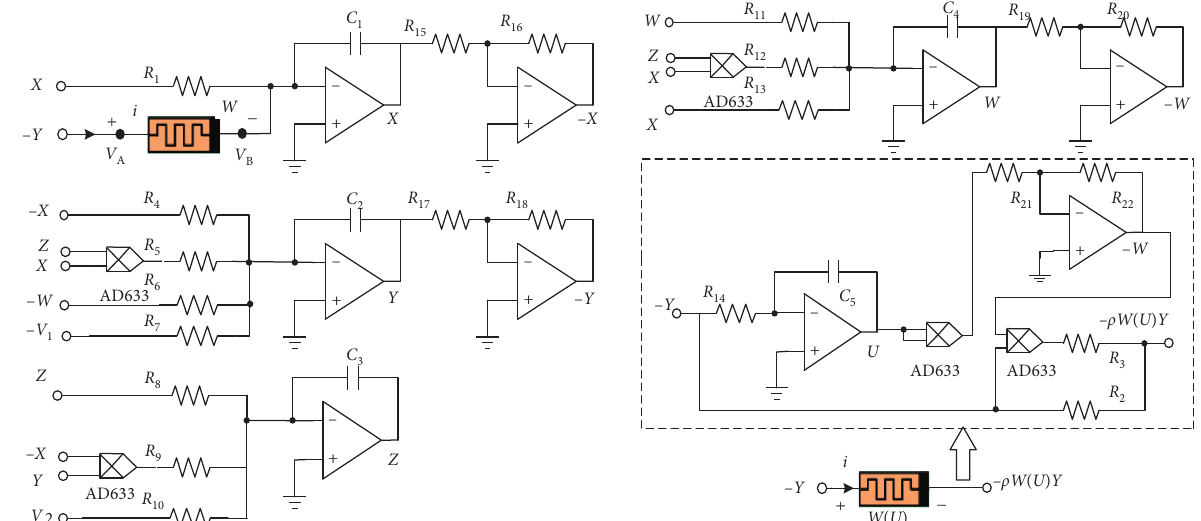
Figure 12: Circuit implementation of the proposed 5D memristive hyperchaotic